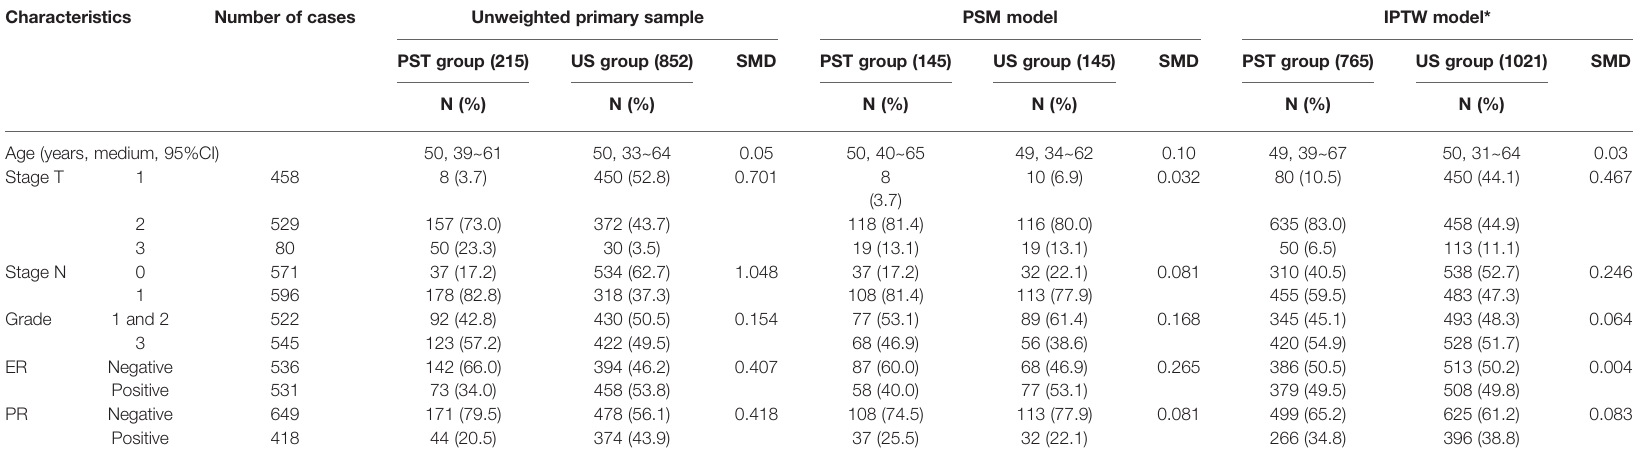
TABLE 3 | The clinicopathologic characteristics of two groups in PSM and IPTW models